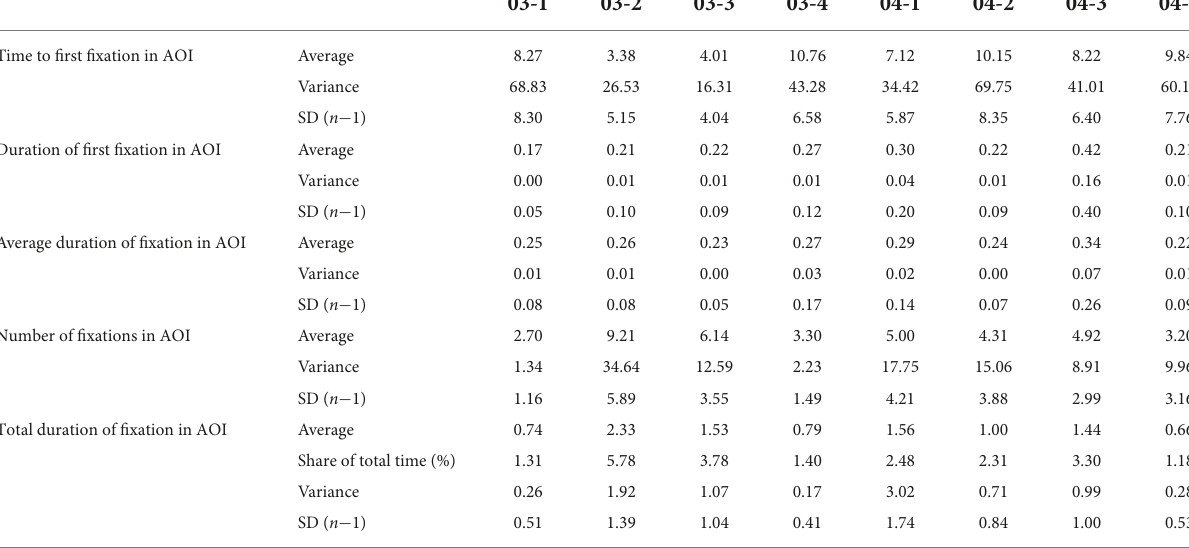
TABLE 3 Eye movement statistics of subjects from AOI 03-1 to AOI